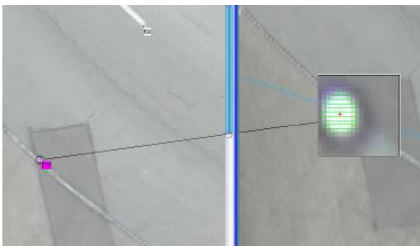
Figure 9. Determination of the target centre points using the centroid operator